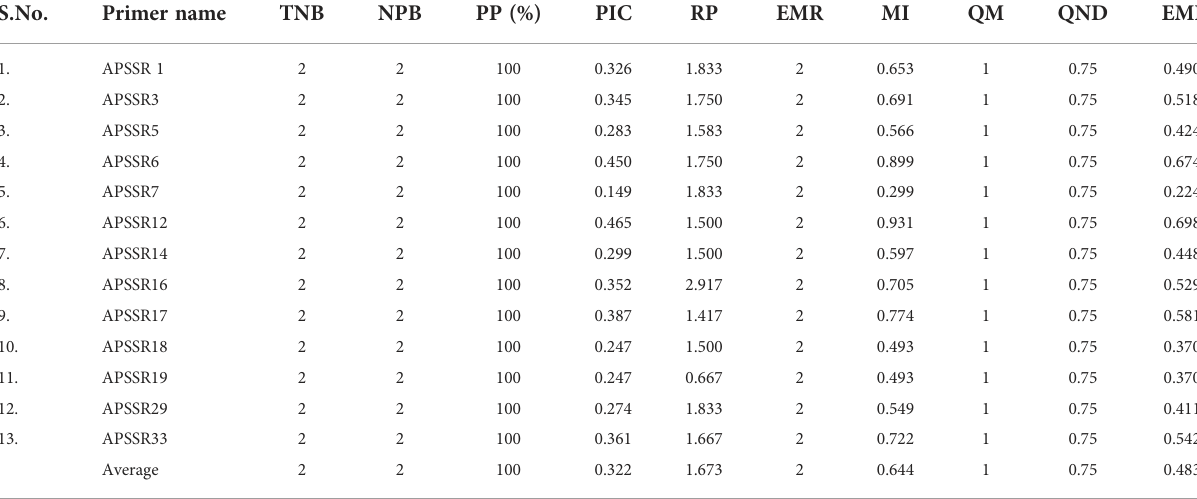
TABLE 1 Genetic parameters of thirteen polymorphic EST-SSRs used in the study.